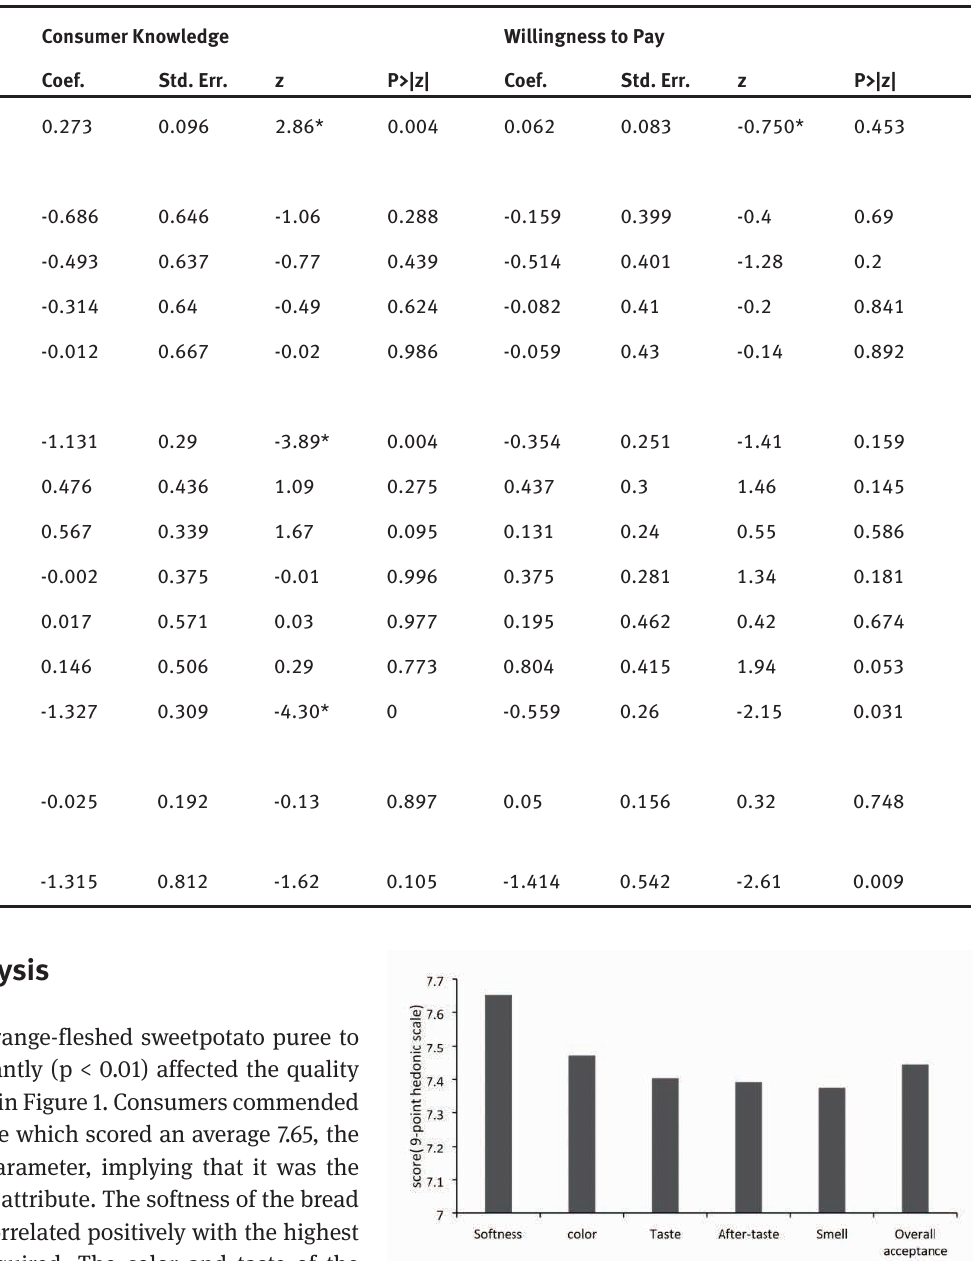
Table 3: Factors that influence consumer knowledge and WTP for OFSP puree-wheat composite bread